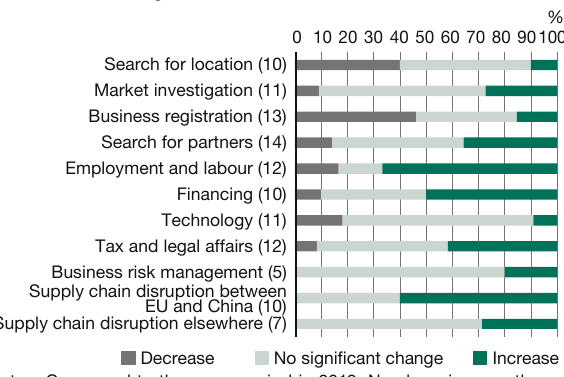
Perceived specifi c development in Chinese investors’ enquiries by investment topic, fi rst half of 2020 Share of fi rms and organisations